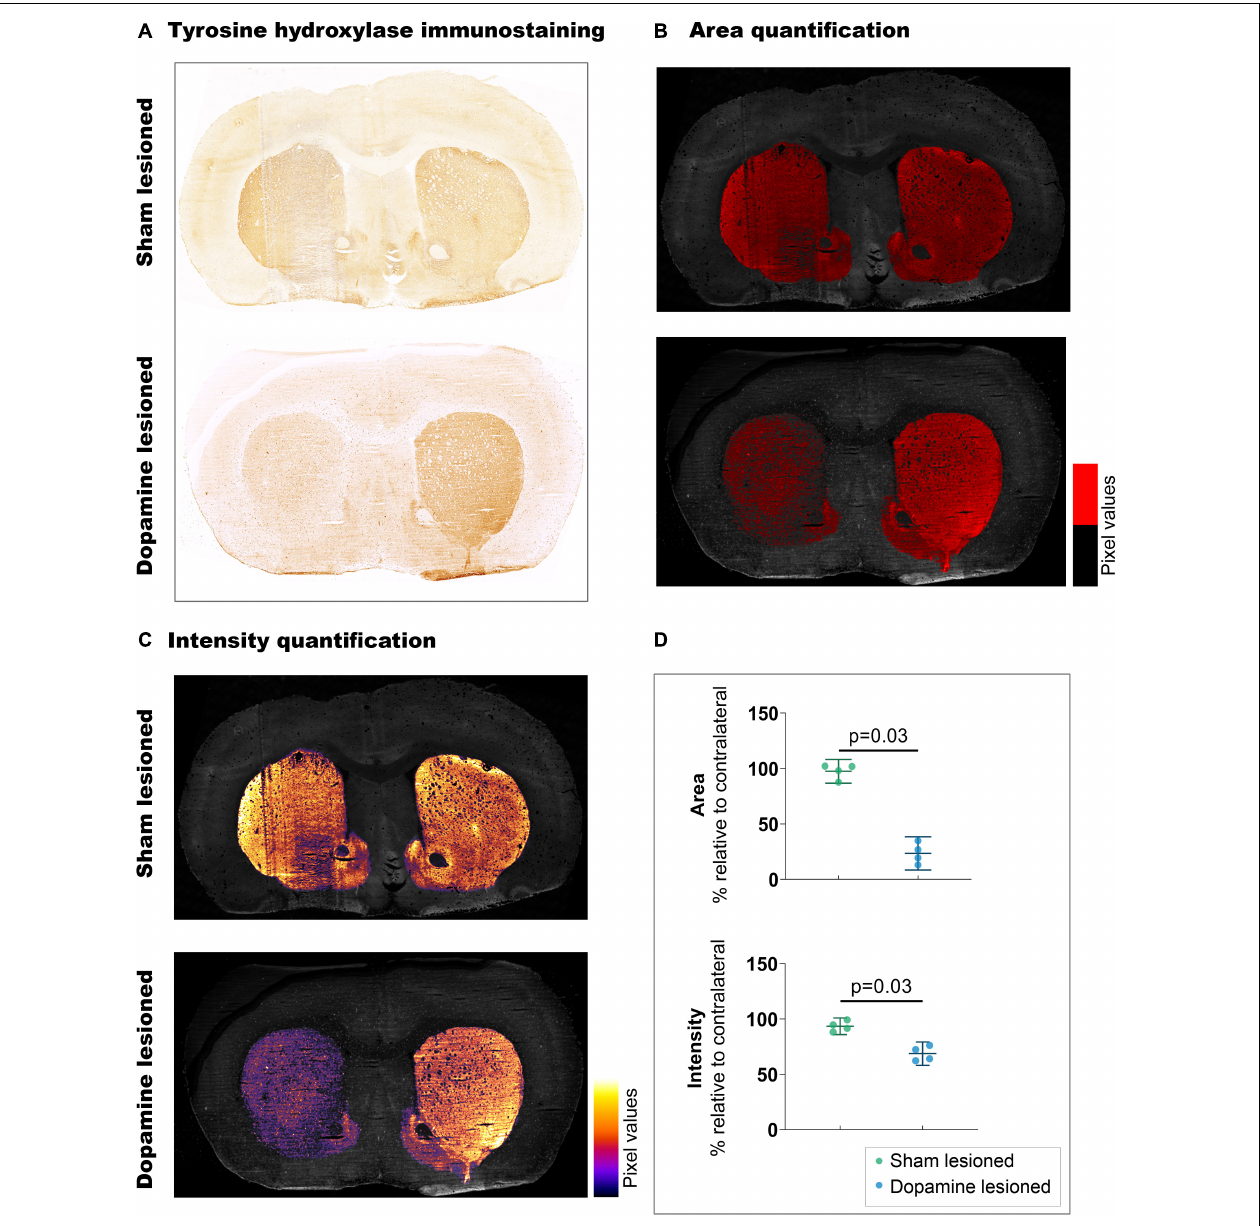
FIGURE 2 | Confirmation of 6-OHDA-induced dopaminergic lesions. (A) Representative example of tyrosine hydroxylate immunostaining: upper section from sham lesioned rats, lower from dopamine lesioned rats. (B) Quantification of the stained area, threshold emphasised in red. (C) Quantification of staining intensity, intensity scale insert. (D) Quantification of intensity and area relative to contralateral striatum ( n = 4/group). Error bar denotes the mean and the 95% confidence interval. P values demonstrated from the Mann-Whitney